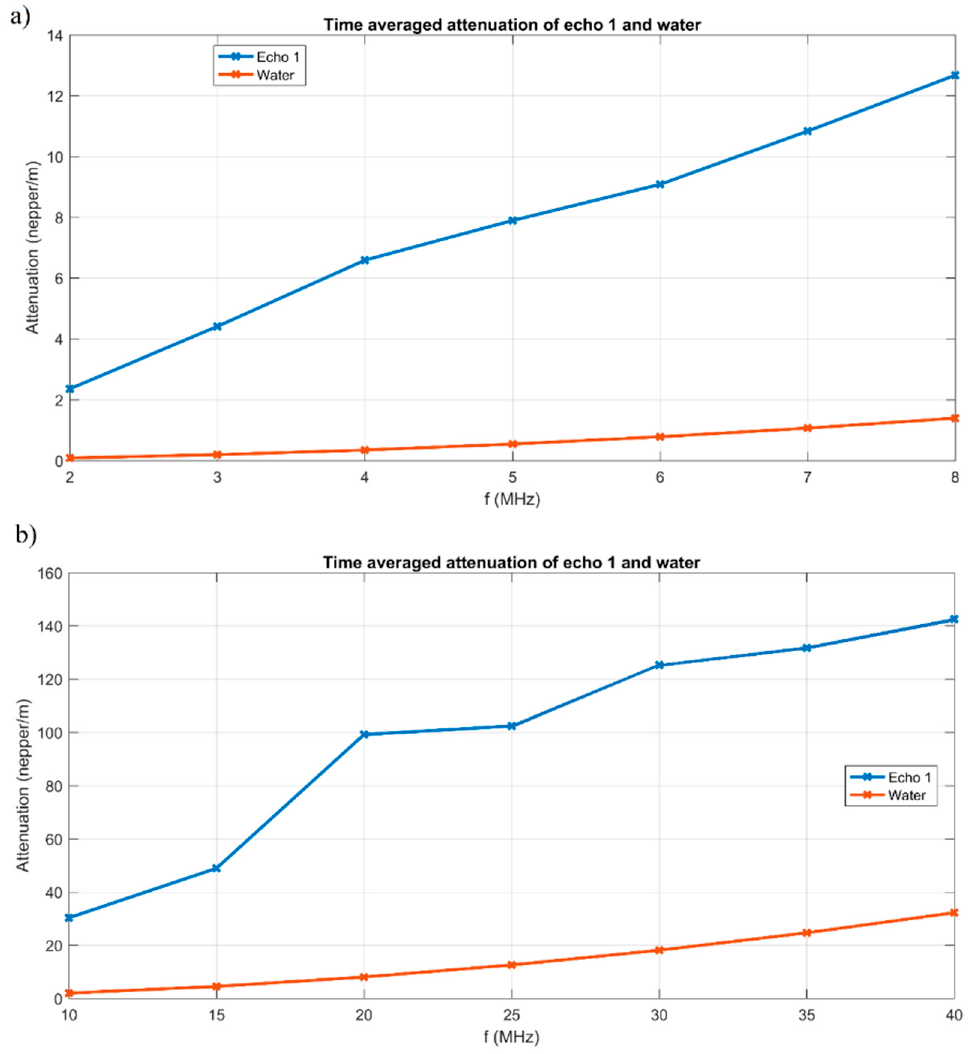
Figure 2. Attenuation vs. frequency for the first transmitted echo at 5 MHz ( a ) and 25 MHz ( b ) central frequency for the AgZnHApCs suspension.